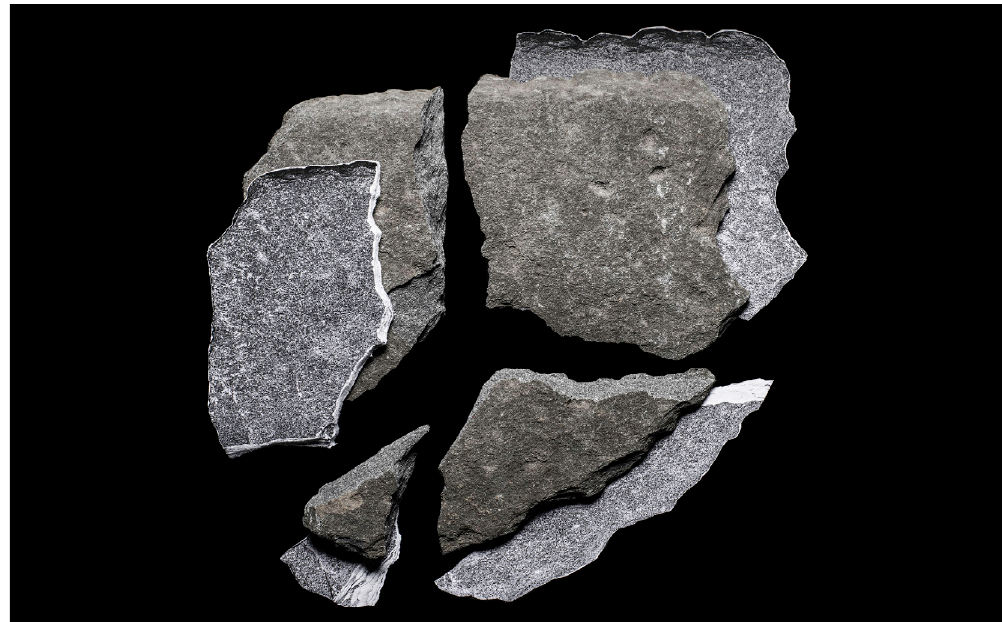
Fig. 4 Kambiz Shafei, Stone Nº12 , 2019, photography, laser print and stone. Basel, Switzerland. Archive of Kambiz